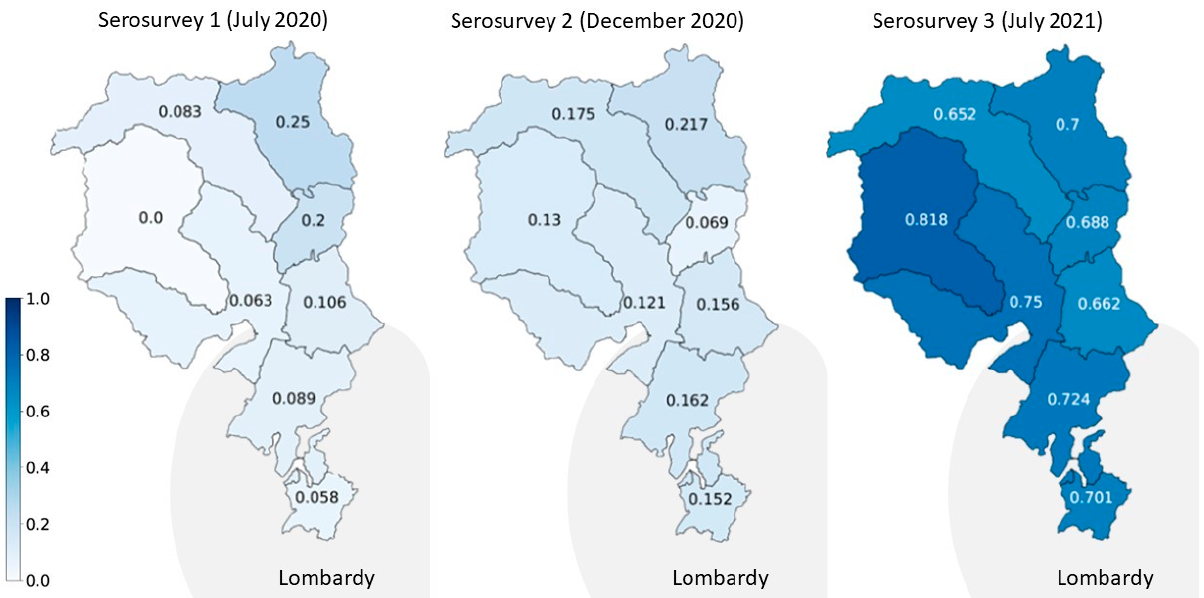
Figure 3. Temporal evolution of proportion of seropositive participants in different geographic regions of southern Switzerland (Ticino). The Italian Lombardy region borders the southern part of Ticino.